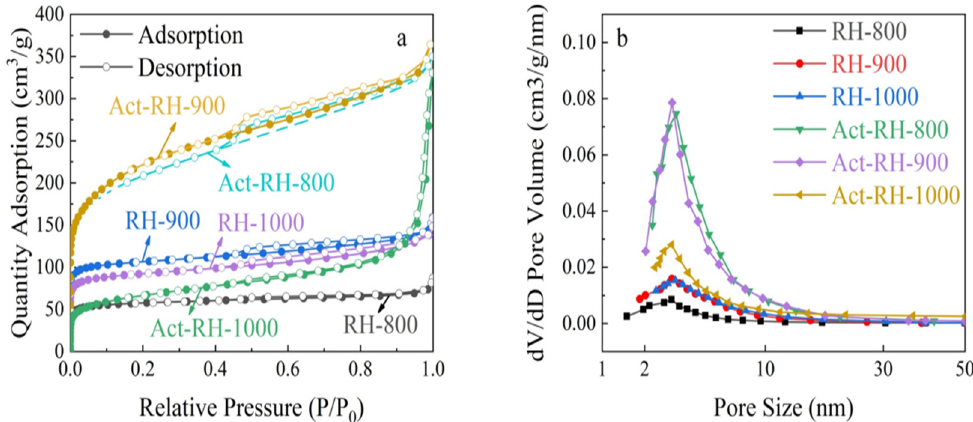
Figure 6. ( a ) Nitrogen adsorption-desorption isotherms and ( b ) pore size distributions of the investigated samples. Table 2. Pore structure parameters of the investigated samples.